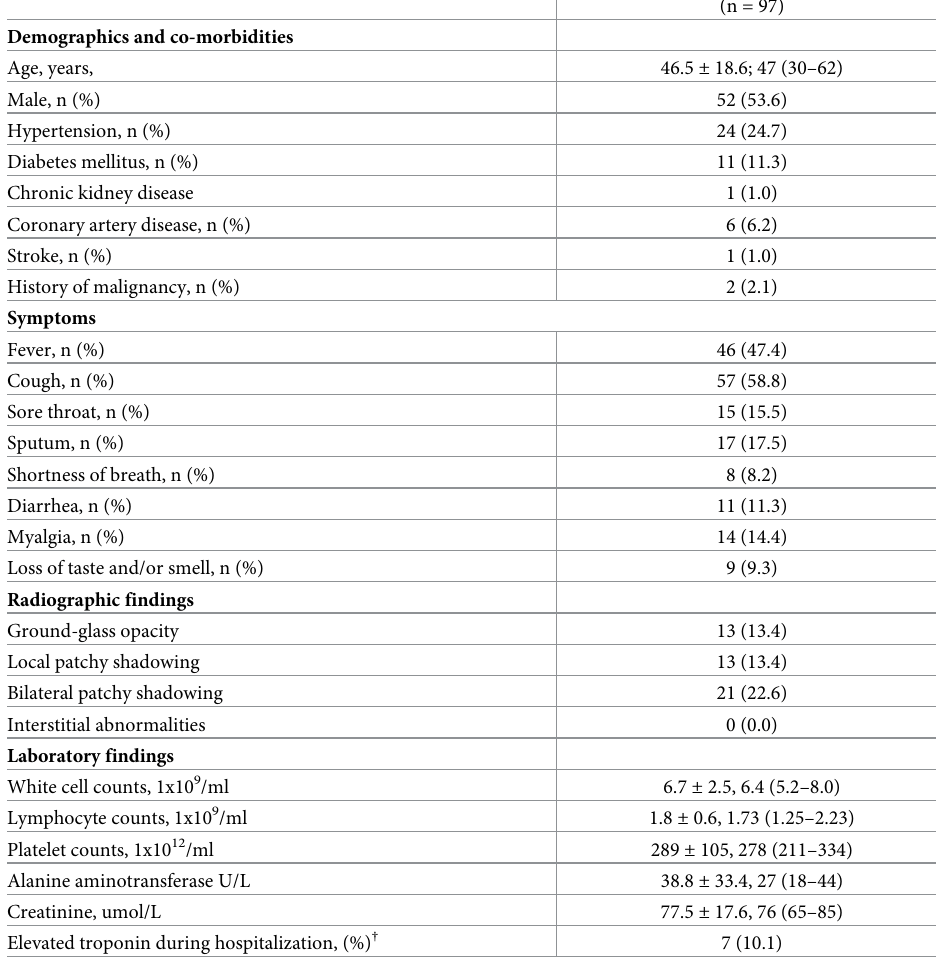
Table 1. Clinical characteristics of the COVID-19 survivors on